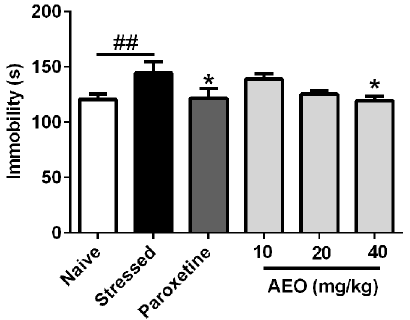
Figure 5. Effects of agarwood essential oil (AEO) on restraint stress-induced depression as tested by the forced swimming test. All mice except for the naive group received 10 days restraint stress, and mice immobility was recorded during a 4 min test period. Each value represents mean ± SEM with n = 12, ## p < 0.01 vs. the naive group, * p < 0.05 vs. the stressed group.